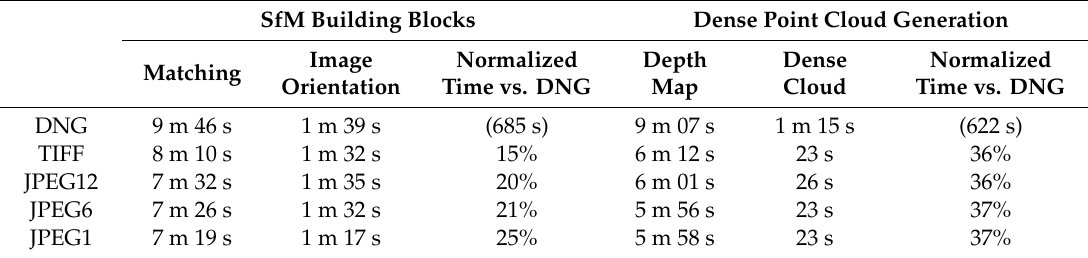
Table 14. Time processing for the experimentation on test site 2.